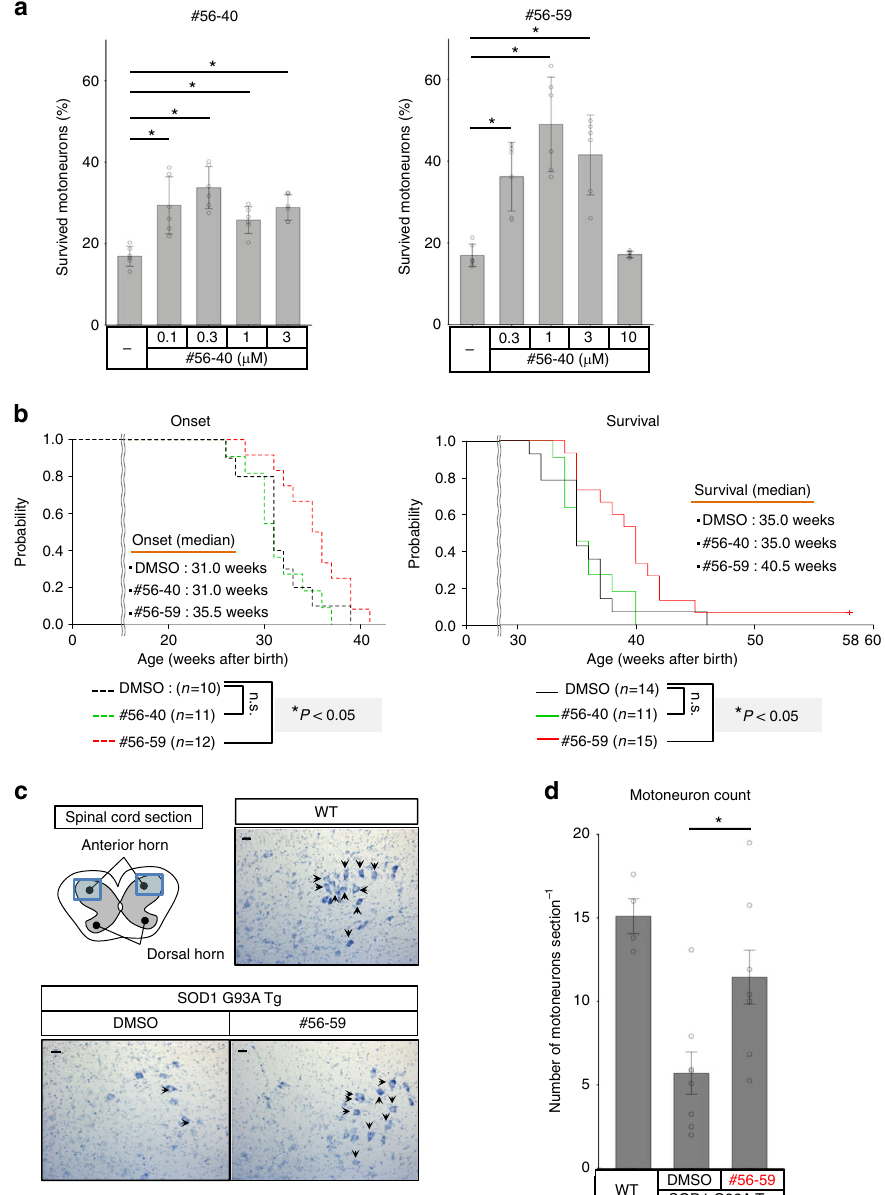
Fig. 5 Inhibiter of SOD1-Derlin-1 interaction, #56-59, ameliorates ALS pathology. a Effects of #56 analogs on motoneurons derived from ALS patient iPSCs with L144FVX mutation in SOD1 (ALS1). The ratios of surviving motoneurons (day 14/day 7 (%)) are shown as the mean ± s.d. ( n = 6; * P < 0.05, also see Methods for statistical test). b Analysis of onset (DMSO: n = 10, #56-40: n = 11, #56-59: n = 12) and survival (DMSO: n = 14, #56-40: n = 11, and #56-59: n = 15) in SOD1 G93A transgenic mice (SOD1 G93A Tg) continuously infused with #56 analogs by i.c.v. cannulation. Onset was determined by motor function de fi cit seen in rotarod performance. Black: DMSO treatment (control); green: #56-40 treatment; red: #56-59 treatment. Mice were followed in this survival study for 58 weeks, and the survival time of one mouse that did not show paralysis is shown as a tick on the line. Statistical analysis was performed using the Kaplan – Meier method followed by the log-rank test and the Gehan – Breslow – Wilcoxon test (* P < 0.05, n.s.: not signi fi cant). c Representative Nissl stain image of the lumbar spinal cord section (L2 – L5) of indicated mice. All motoneuron counts were performed in a blinded fashion. Scale bar = 20 μ m. d Quanti fi cation of motoneuron counts in c . Five sections per mouse were counted, and the data are shown as the mean ± s.e.m. WT mice: n = 4; DMSO-treated and #56-59-treated SOD1 G93A Tg: n = 8 in each group, * P < 0.05: signi fi cance was calculated using Student ’ s t